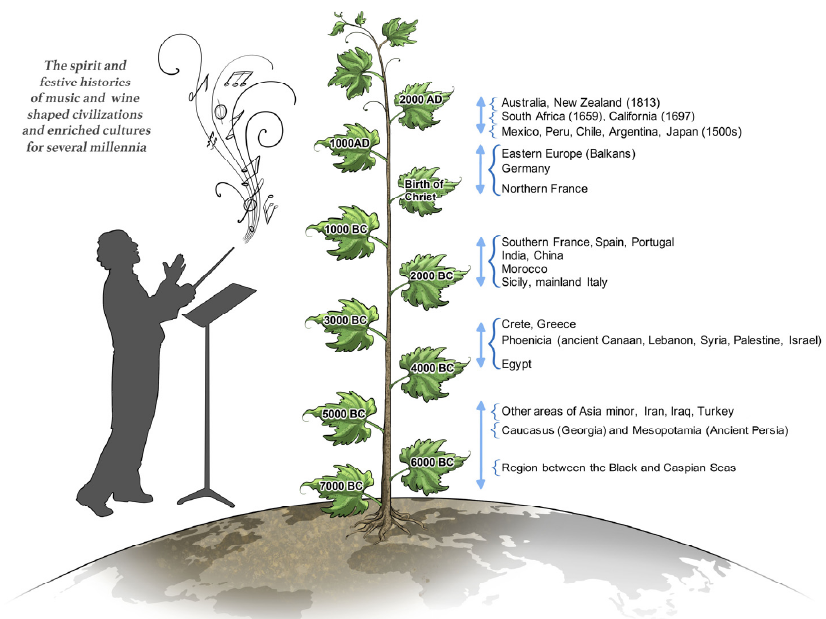
Figure 1. The spread of producing wine from Vitis vinifera noble grape varieties from Asia minor (around 6500 BC) to other parts of the world. (Adapted from [1]).